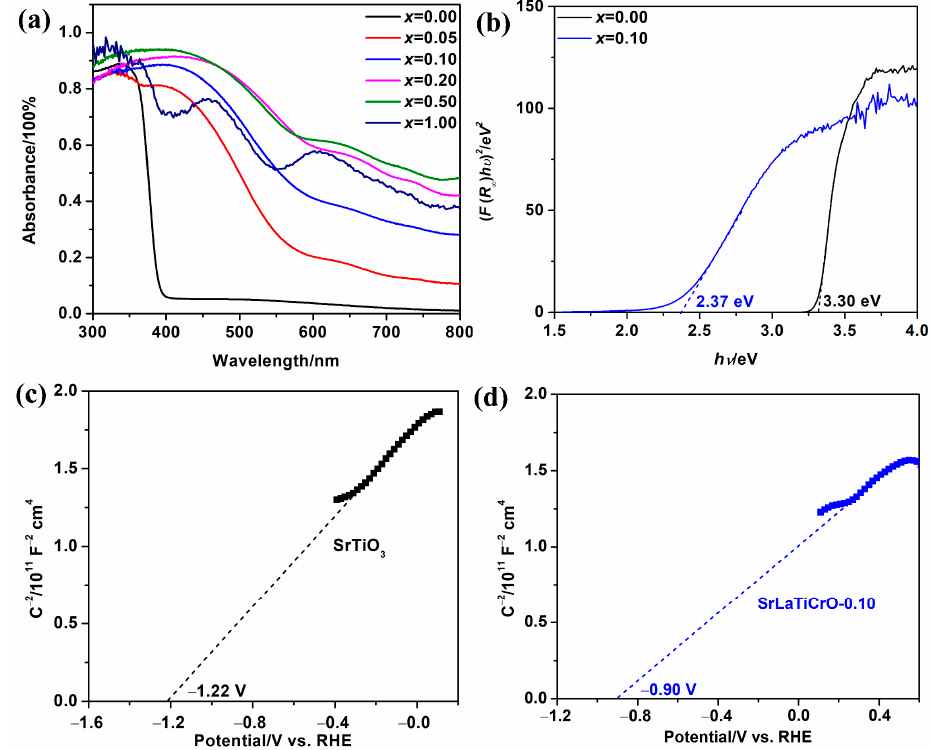
Figure 4. ( a ) UV–Vis spectra of the as-prepared SrLaTiCrO-x samples with x equal to 0.00, 0.05, 0.10, 0.20, 0.50 and 1.00. ( b ) Tauc plots of SrTiO 3 and SrLaTiCrO-0.10. M–S curves of ( c ) SrTiO 3 and ( d ) SrLaTiCrO-0.10.